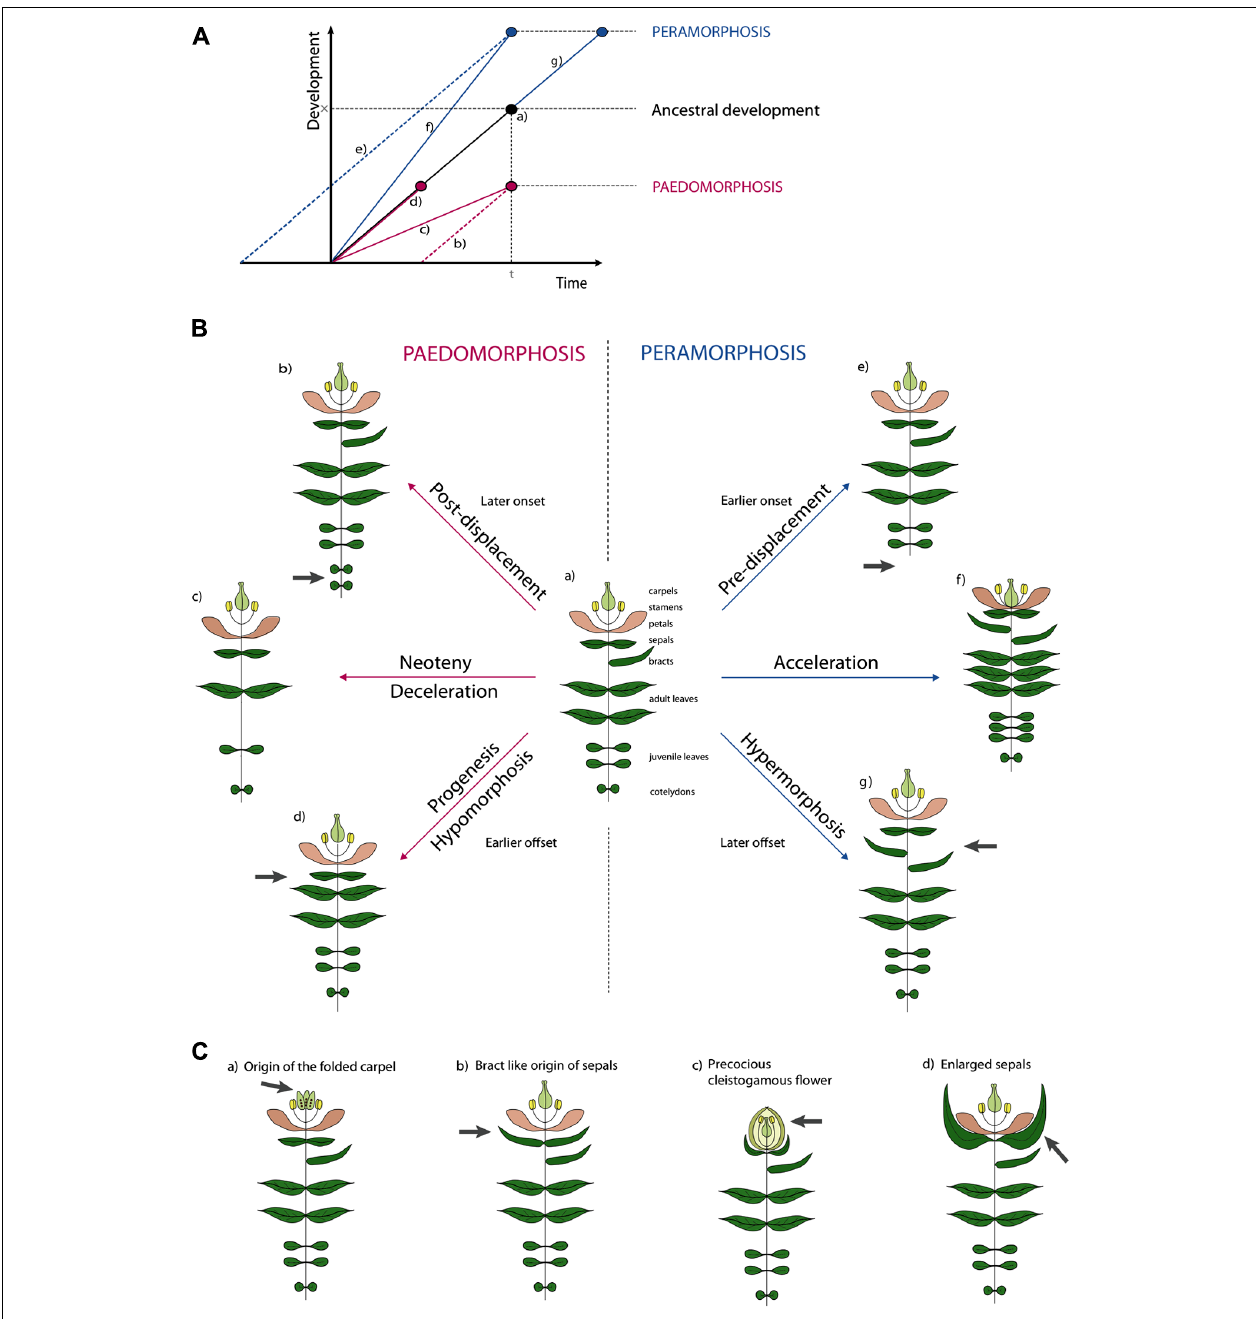
rate is increased. Finally, in hypermorphosis (g) development is continued after normal offset. (B) Hypothetical examples of heterochrony. Figure (a) shows a reference plant with different types of plant organs. Peramorphic develop “beyond” this, while paedomorphic plants retain juvenile features. In post-displacement (b) , onset is later and an additional pair of cotyledons develops, in pre-displacement (e) , onset is later and no cotyledons develop. In neoteny, less organs develop with larger internodes (c) , while in acceleration (f) , more organs develop with shorter internodes. In progenesis (d) , offset is earlier and no bract develop, while in hypermorphosis (g) , offset is later and additional bracts develop. (C) Examples of heterochrony taken from the literature. See text for